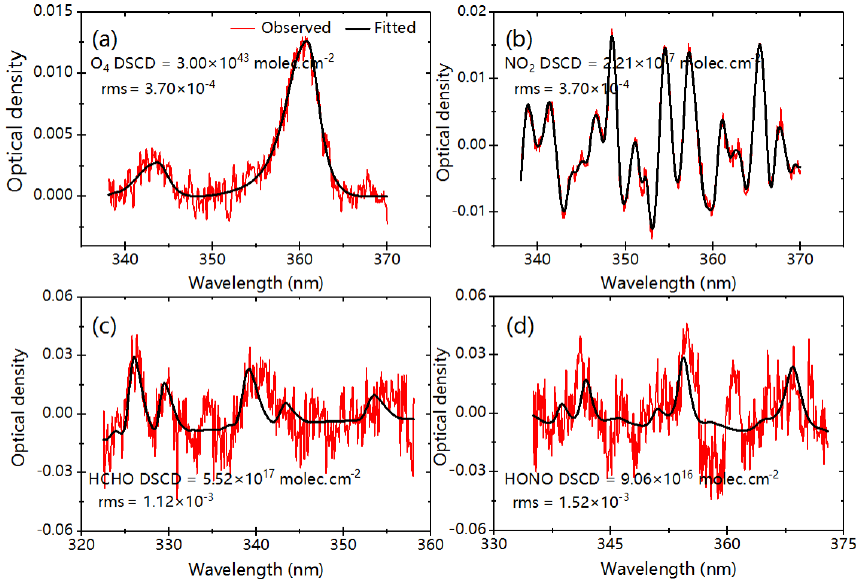
Figure 3. Examples of DOAS fits for O 4 , NO 2 , HCHO and HONO ( ∼ 13:30LST on 22 May 2018; SZA and elevation angle (EVA) values were 52.53 and 15 ◦ ,